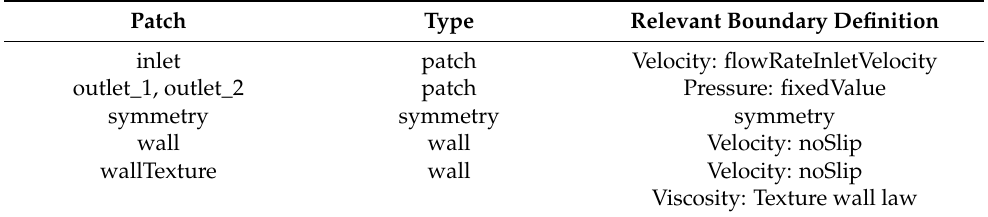
Table 6. D-ring: boundary conditions.